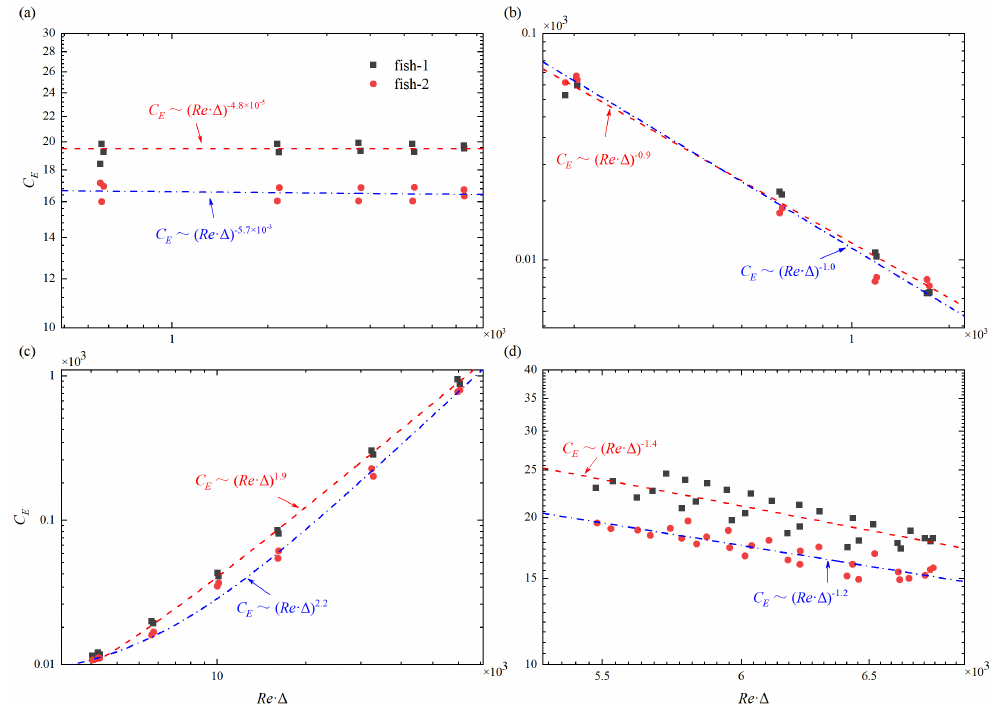
Figure 10. The energy consumption coefficient varies as a function of the Reynolds number and different change of ( a ) initial separation distance ( ∆ = d 0 ), ( b ) tail beat amplitude ( ∆ = A ), ( c ) wave length ( ∆ = λ ), and ( d ) period of oscillation ( ∆ = T